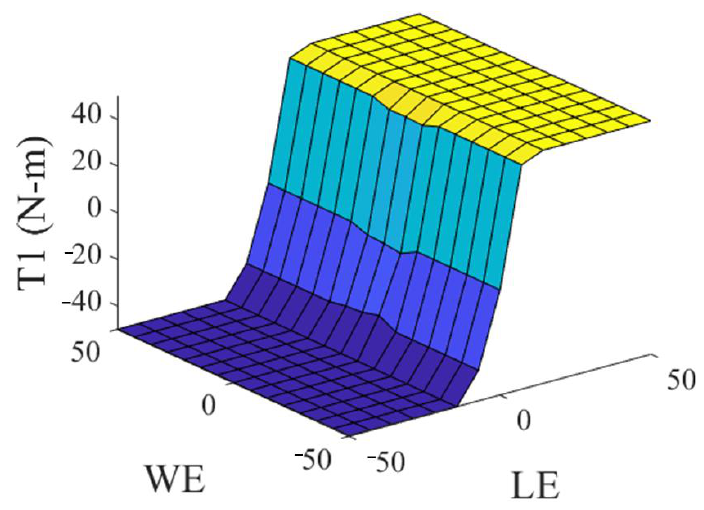
Figure 5. Antecedent of the GT2FC. The parameters for the GT2MF construction of antecedents are presented in Table 2. Table 2. GT2MF antecedent parameters.